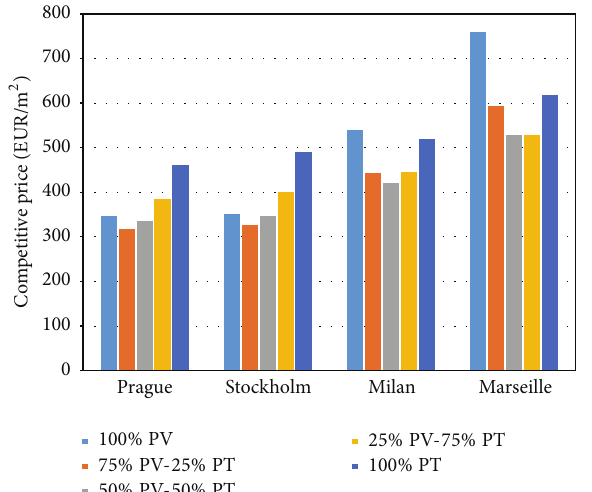
Figure 9: Competitive specific price of glazed selective hybrid PVT